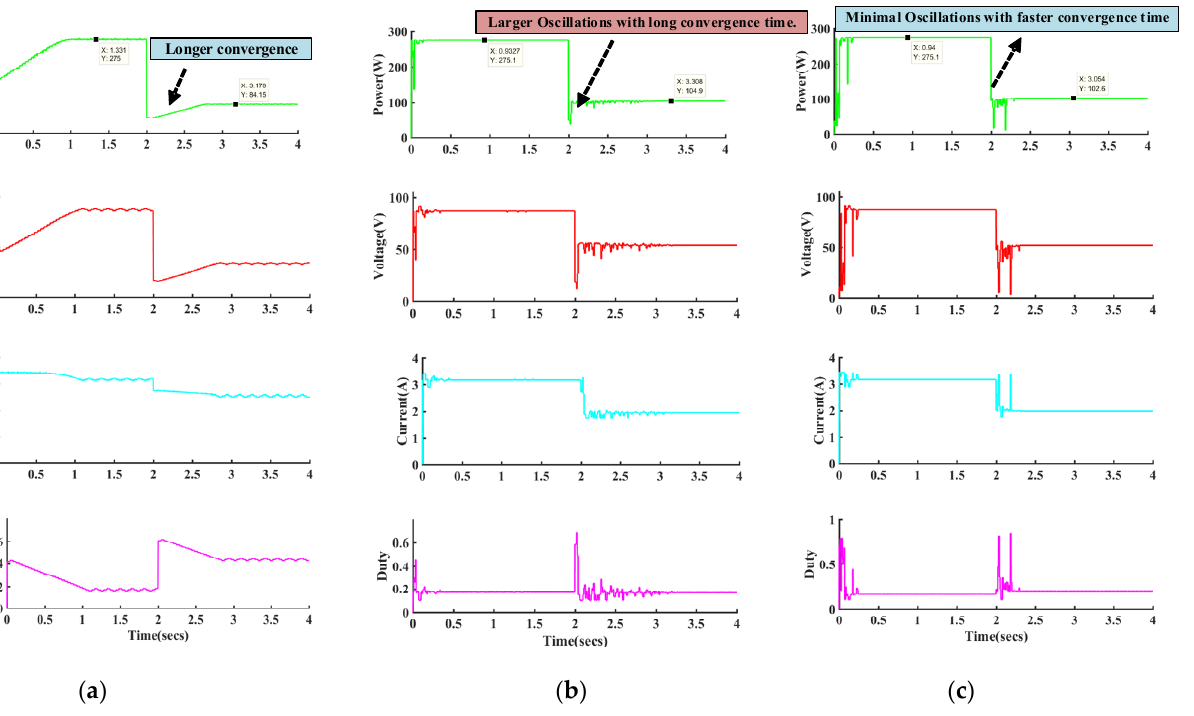
Table 2. Comparative analysis of P and O, PSO, and SHO methods.